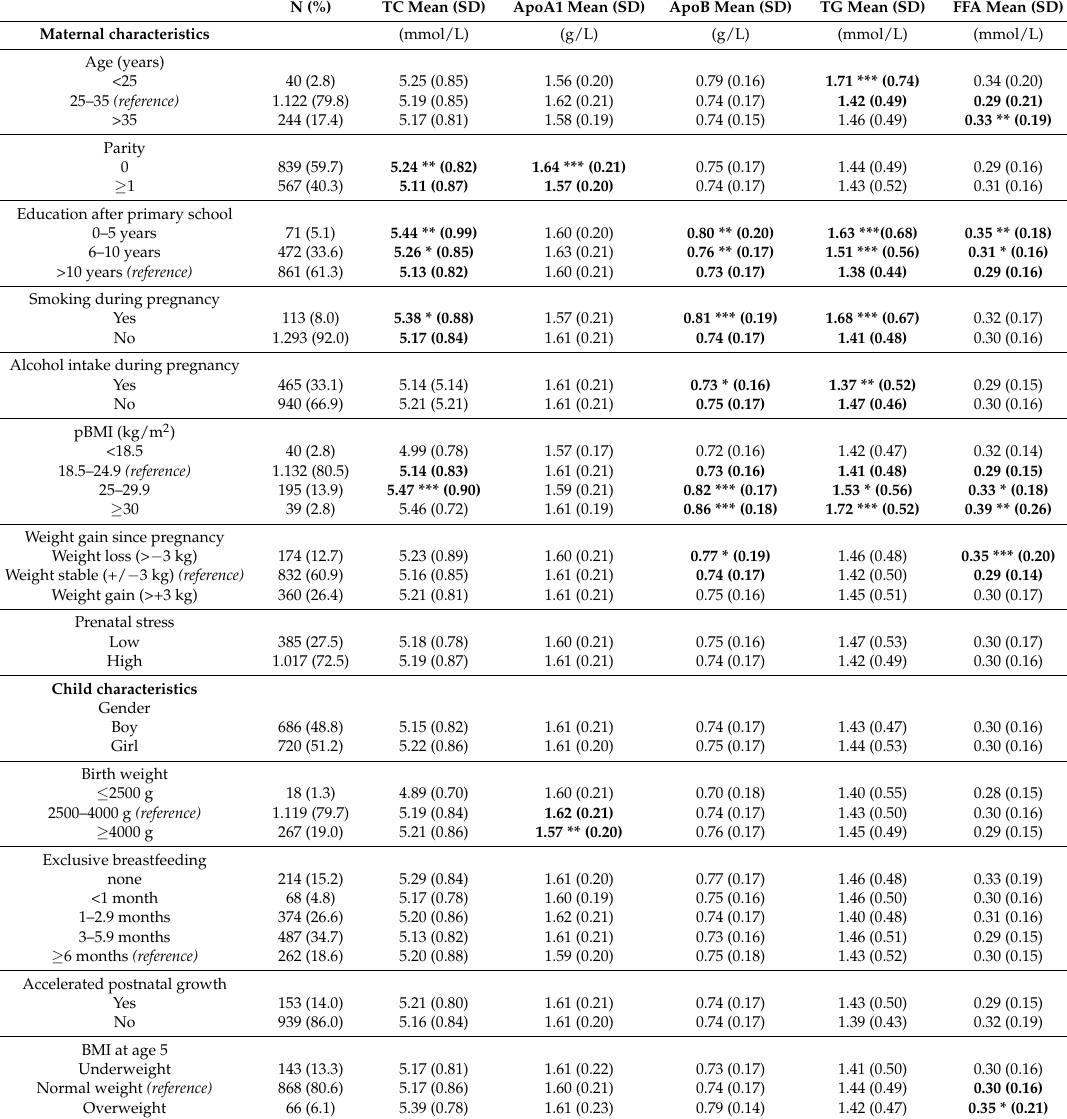
Table 1. Maternal lipid concentrations according to maternal and offspring